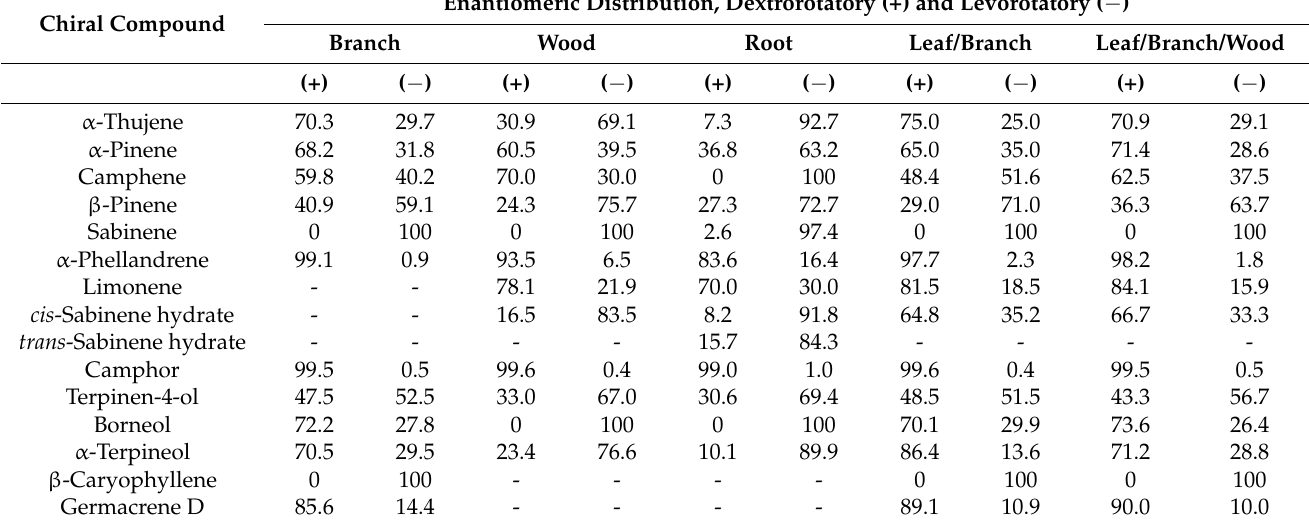
Table 3. Enantiomer distributions of chiral terpenoid of Cinnamomum camphora L. essential